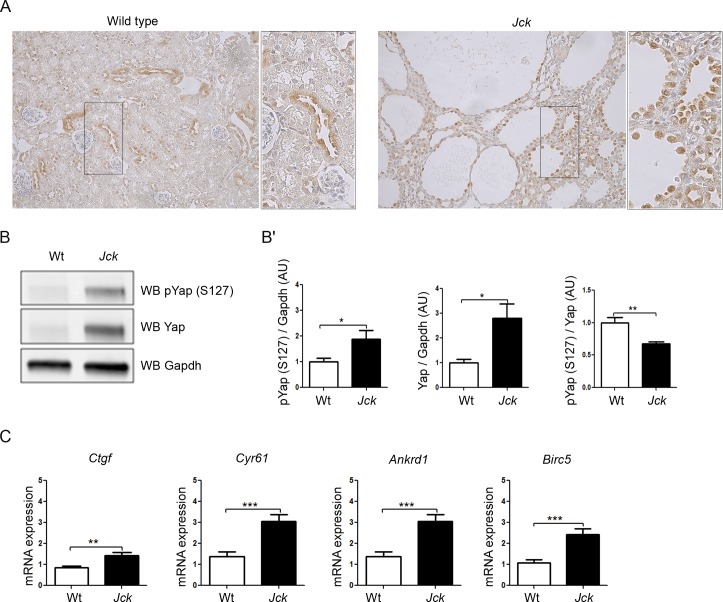
Yap and Yap target gene expression are induced in Jck mice.(A) Immunohistochemistry of Yap in wild-type (Wt) and Jck mice at 5 weeks of age (n = 4 of each). (B-B’) Western blot analysis (B) and quantification of YAP and phospho-YAP (S127) expression (B’) in Wt (n = 8) and Jck mice (n = 8) at 5 weeks of age. **p < 0.01, calculated by Mann-Whitney test. (C) Relative quantification of Yap targets Ctgf, Cyr61, Ankrd1 and Birc5 mRNA expression in wild-type (n = 10) and Jck mice (n = 8) at 5 weeks of age. **p < 0.01, ***p < 0.001, calculated by Mann-Whitney test.